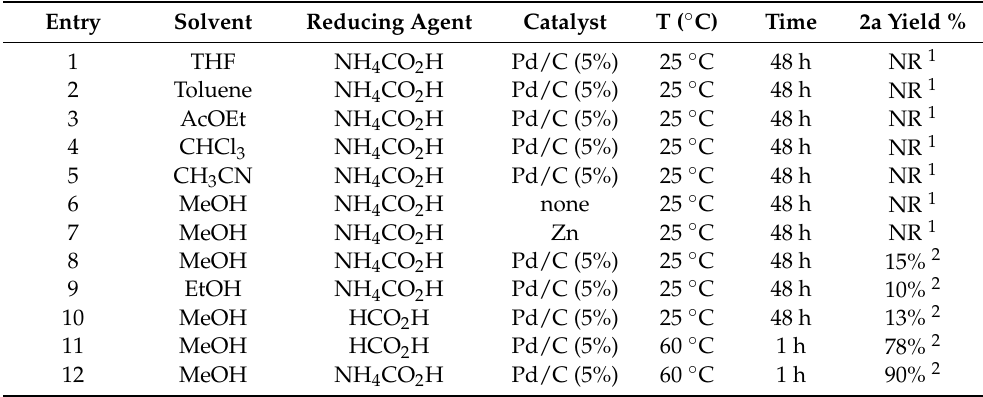
Table 1. Optimization of reduction reaction of 1,2,4-oxadiazole 1a .